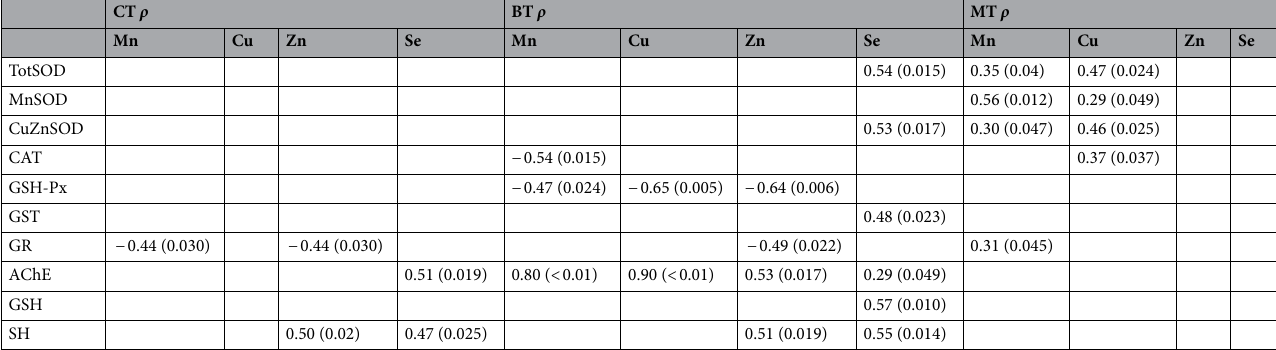
Table 4. Calculation results of nonparametric Spearman’s rank correlation coefficients between oxidative stress parameters and selected trace elements in control brain tissue (CT), benign tissue (BT) and malignant tissue (MT). *Exact P values are in